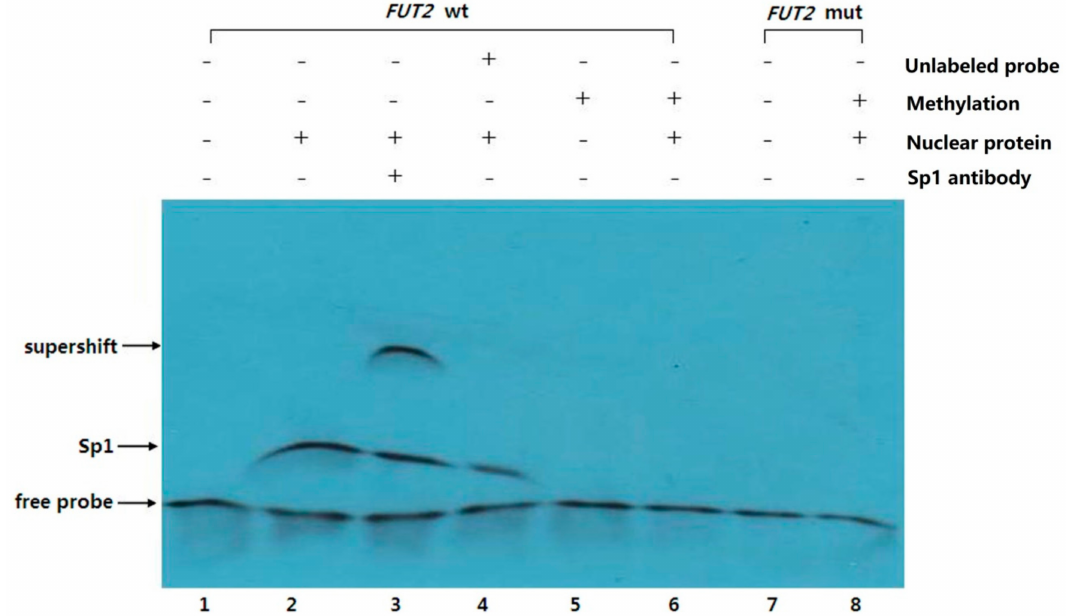
Figure 8. The electrophoretic mobility shift assay (EMSA) analysis of Sp1 binding to the FUT2 promoter. Nuclear proteins from duodenal tissues expressing Sp1 were extracted using the nuclear protein extraction kit. All products were electrophoresed on a non-denaturing 5% polyacrylamide gel. After electrophoresis, DNAs were transferred to a positive nylon membrane, UV cross-linked, probed with a streptavidin-HRP conjugate and incubated with the substrates of the ECL kit. All free biotin-labeled probes ( FUT2 wt, Lanes 1–6; FUT2 mut, Lanes 7 and 8) were detected by streptavidin-HRP. The Add unlabeled probe in Lane 4 was a cold competitor. Probes in Lanes 5 and 6 and Lane 8 were treated